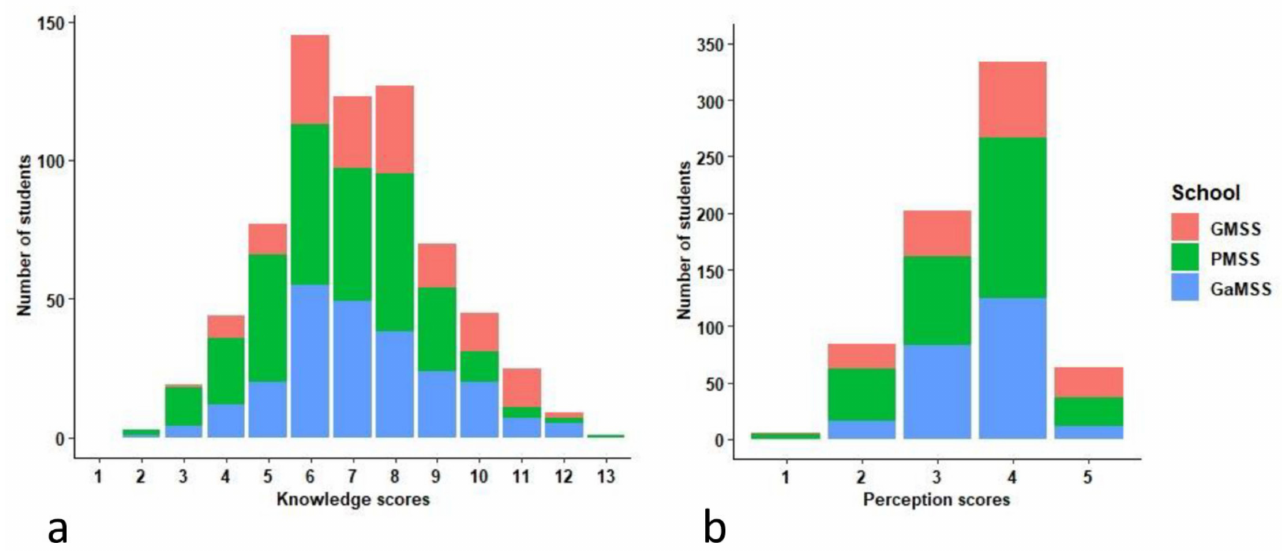
Figure 5. Distribution of knowledge and perception scores among students of three selected school: ( a ) Knowledge scores; ( b ) Perception